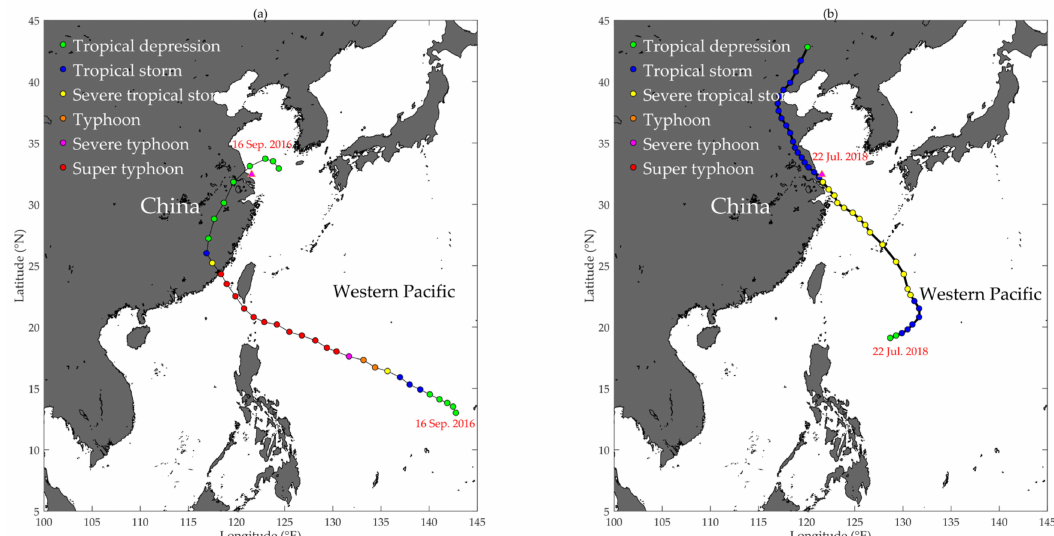
Figure 13. The trajectory of tropical cyclone (TC) Meranti ( a ) during 9~16 September 2016 and TC Ampil; ( b ) during 18~22 July 2018. The TC categories are labelled by circles in different colours. The Huo Xing Sha platform (magenta triangle) is near the trajectory of Meranti on 16 September 2016, when the TC category changed to a tropical depression and that of Ampil on 22 July 2018, when the TC category changed from severe tropical storm to tropical storm. The TC trajectory data were obtained from the China Meteorological Administration (CMA).